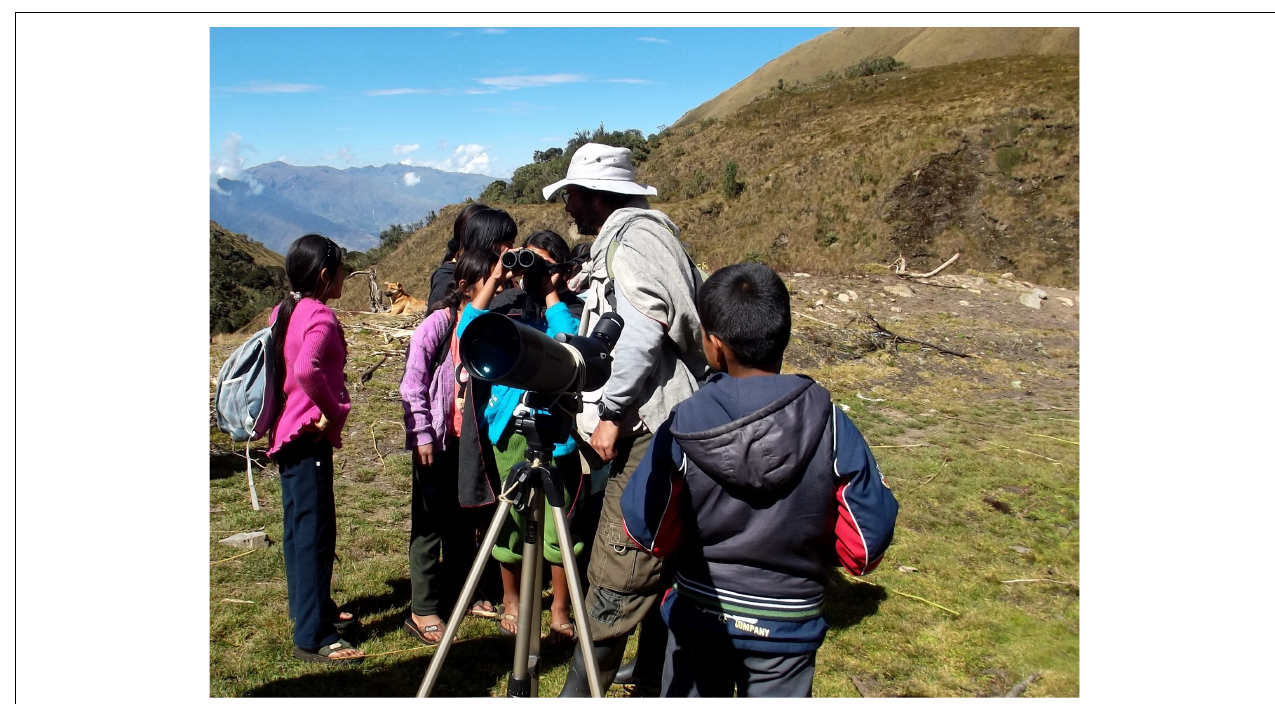
FIGURE 9 | Teaching Pentecostal children about birds in the Peruvian Andes (Gonzalez